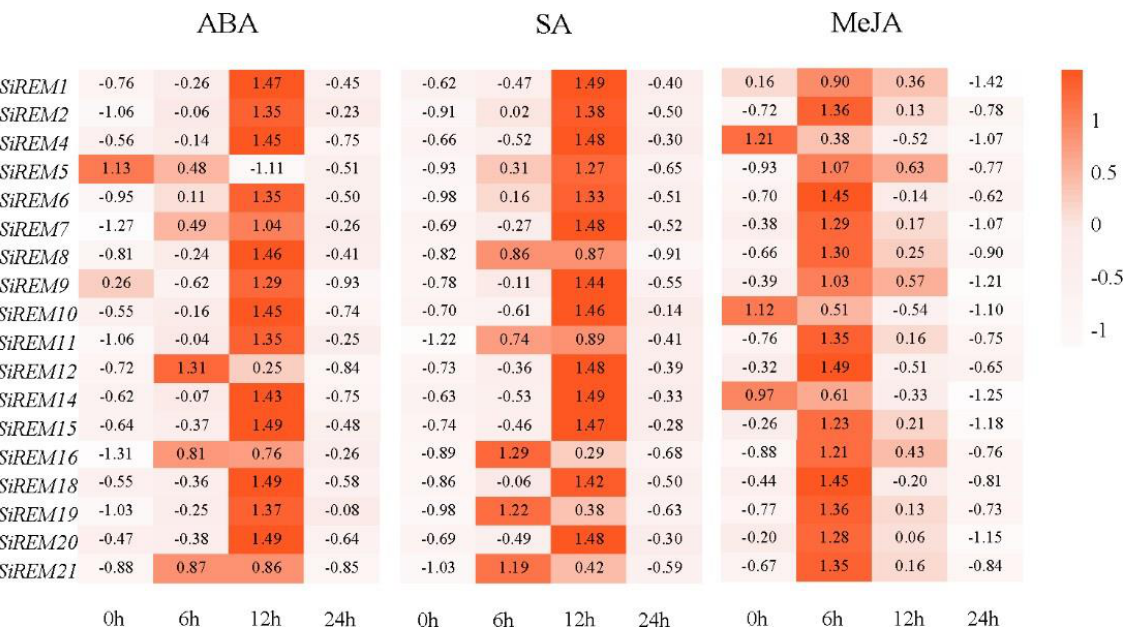
Figure 6. Expression profile of SiREM genes under different hormone treatments. Orange bars indicate up-regulation, white bars indicate down-regulation, and the intensity of the color indicates the intensity of expression.